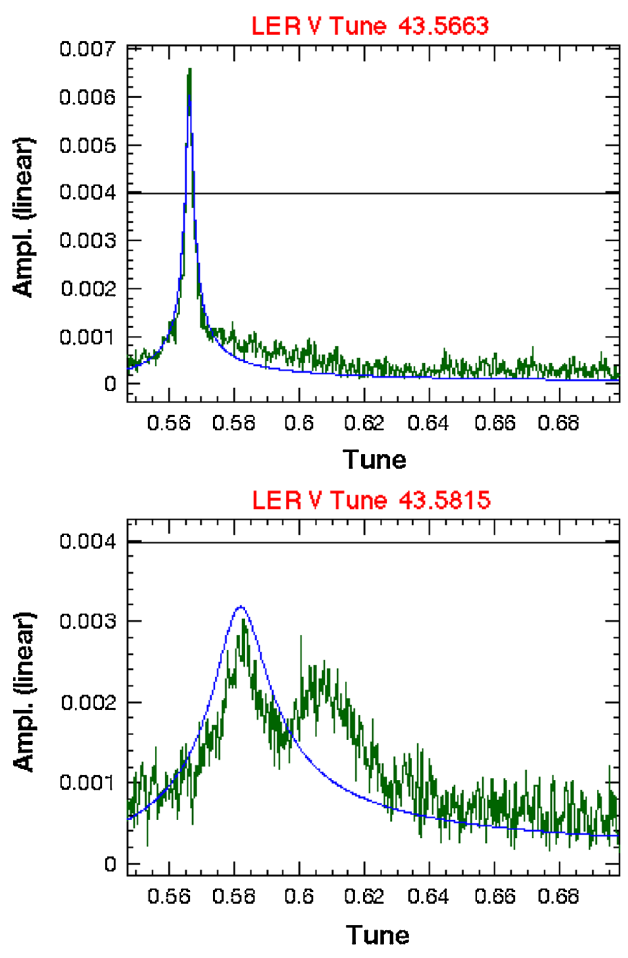
FIG. 7. (Color) Vertical tune spectra of a positron bunch at bucket number 0 (upper) and 4753 (lower). The bunch currents of the positron and electron are 0.93 and 0.45 mA, respectively. The total currents of the positron and electron are 1600 and 850 mA, respectively. An amplitude of 1.0 in the vertical scale corresponds to an oscillation amplitude of 0.3 mm.